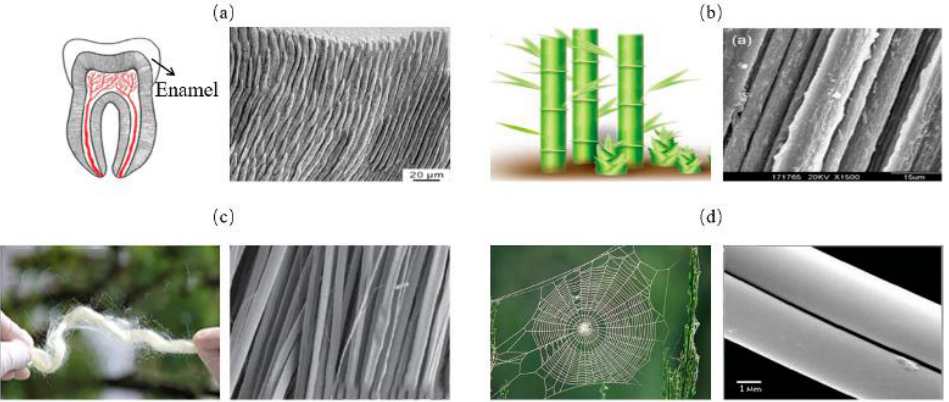
Figure 4. Columnar model in biological organisms. ( a ) tooth enamel [32] Copyright©2009, Bio-